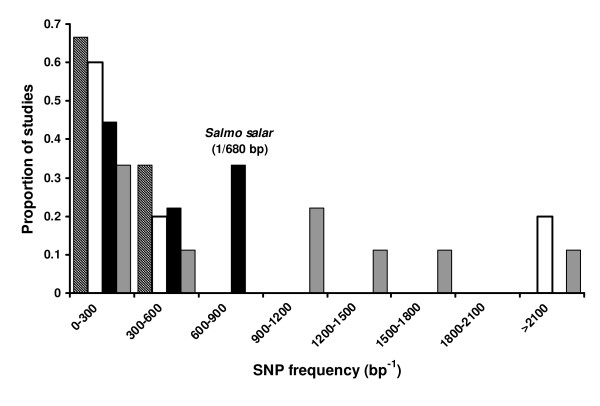
SNP frequencies in four salmonid species observed in this study and from 25 selected multi-locus studies of various organisms. Different species were split into four taxonomic groups: plants (n = 6, hatched bars), birds (n = 5, white bars), fish (n = 9, black bars), and mammals (n = 9, grey bars). Estimates were obtained from the following publications: [4, 9, 12, 16, 71]; [2] and references therein; [20, 23, 37, 72-74]; unpublished data, Hayes et al.